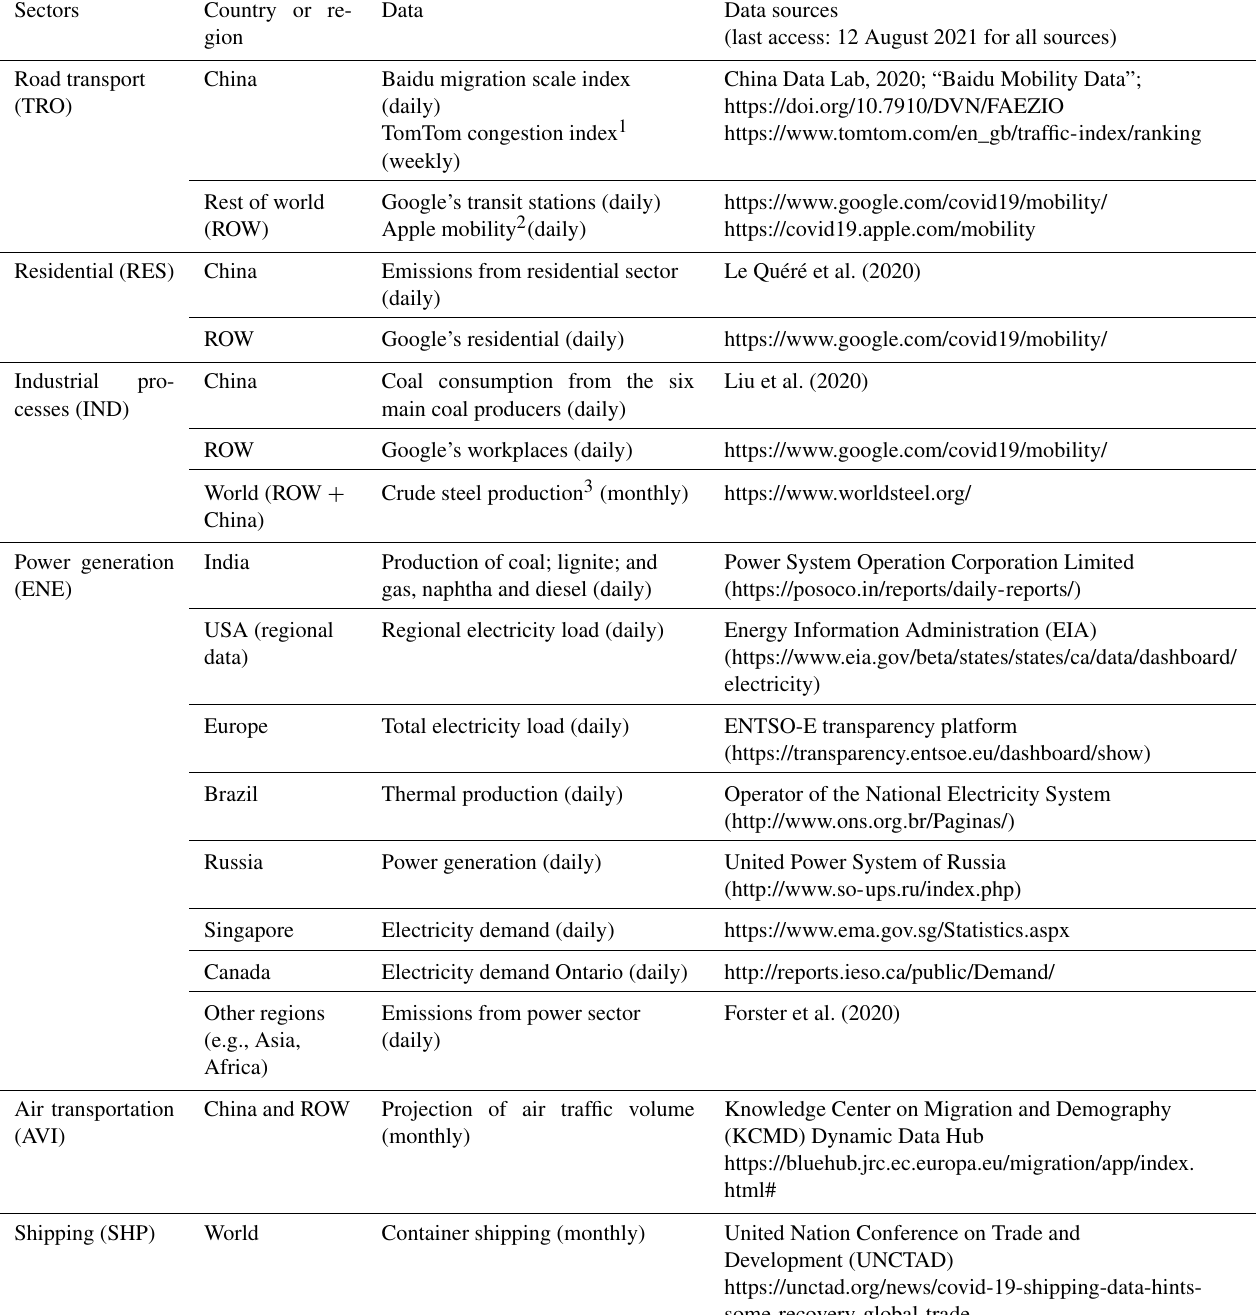
Table 1. Data sources of activity data used to estimate the emission AFs. In this table, rest of world (ROW) refers to all world countries except